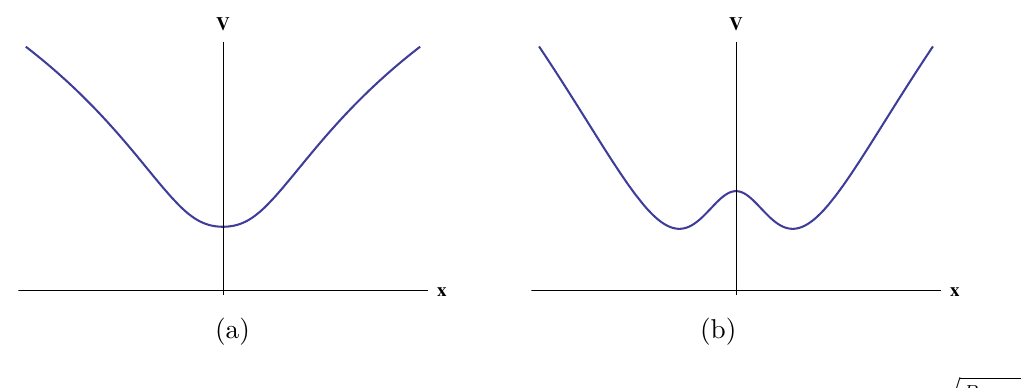
Figure 1 . The potential has a minimum at x = 0 for B < A and two minima at x = ± for B > A . In figure a), A = 2 , B = 1 . 5 . Figure b) A = 2 , B = 3 . 5